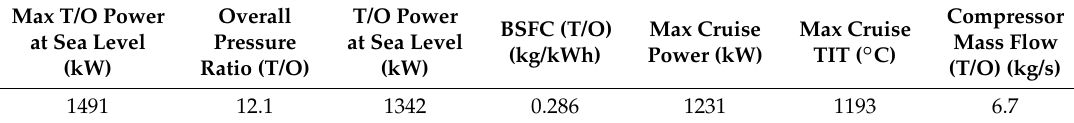
Table 1. Engine1 (PW120) features. Table1. Engine1 (PW120) features. Table1. Engine1 (PW120) features.